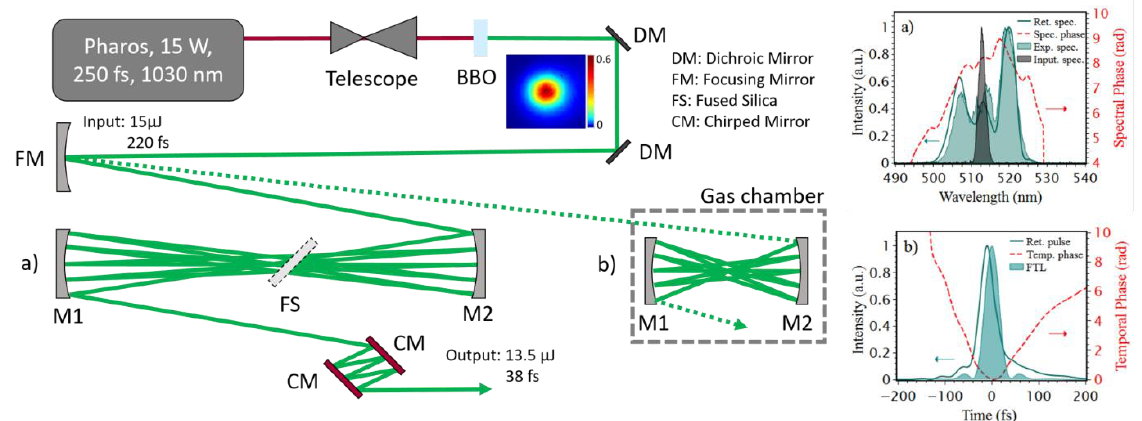
Fig. 1 Left: Experimental setup for pulse broadening and compression in the 515 nm spectral region. The 1030 nm IR- beams originated from a commercial laser (Light Conversion PHAROS) are frequency-doubled in a BBO crystal